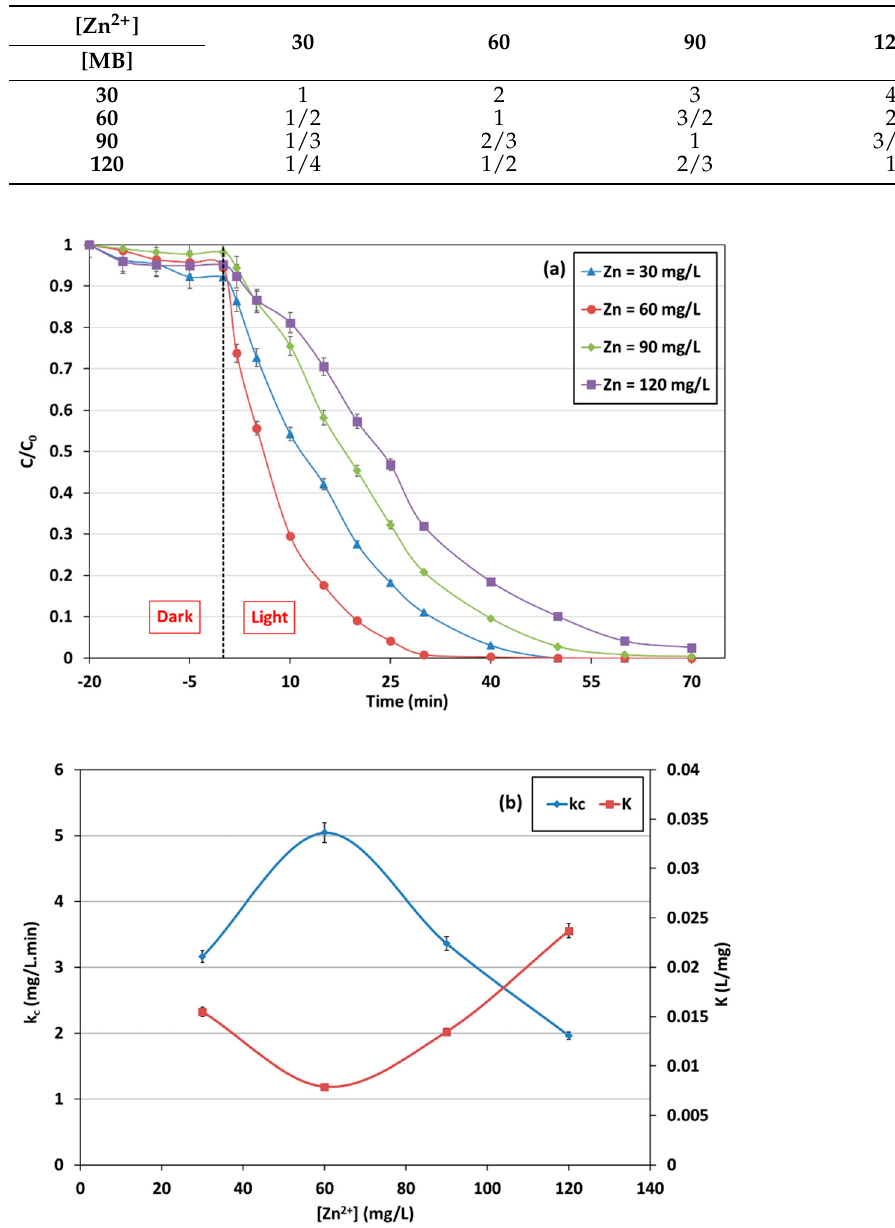
Table 4. Matrix of experiments to determine the UV-photocatalysis of methylene blue in the presence of zinc (mg/L) (pH neutral, T ◦ = 20 ± 2 ◦ C, D TiO